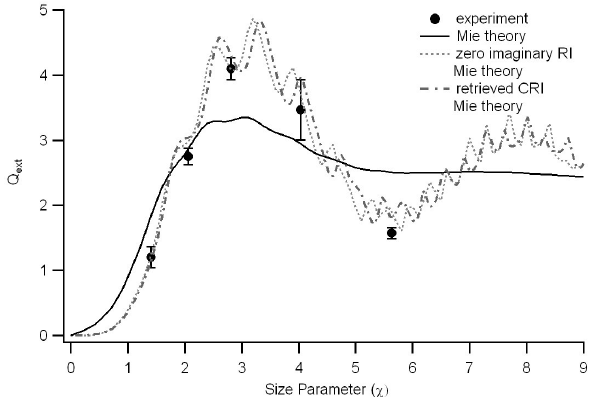
Figure 9. At a wavelength of 335 nm, the Q ext measured by the AE-DOAS (solid black circles) does not match the Q ext predicted by Mie theory generated with the French et al. (2007) CRI ( m = 1.686 + 0.197 i ) shown as the black line. The Mie theory generated when the imaginary portion of this CRI is reduced to zero is shown in the light gray dotted line. The grey dot-dash line is the Mie theory calculation for the CRI retrieved from the experimental data ( m = 1.72 + 0.005 i ). Errors bars are 1 σ on repeat experimental measurements